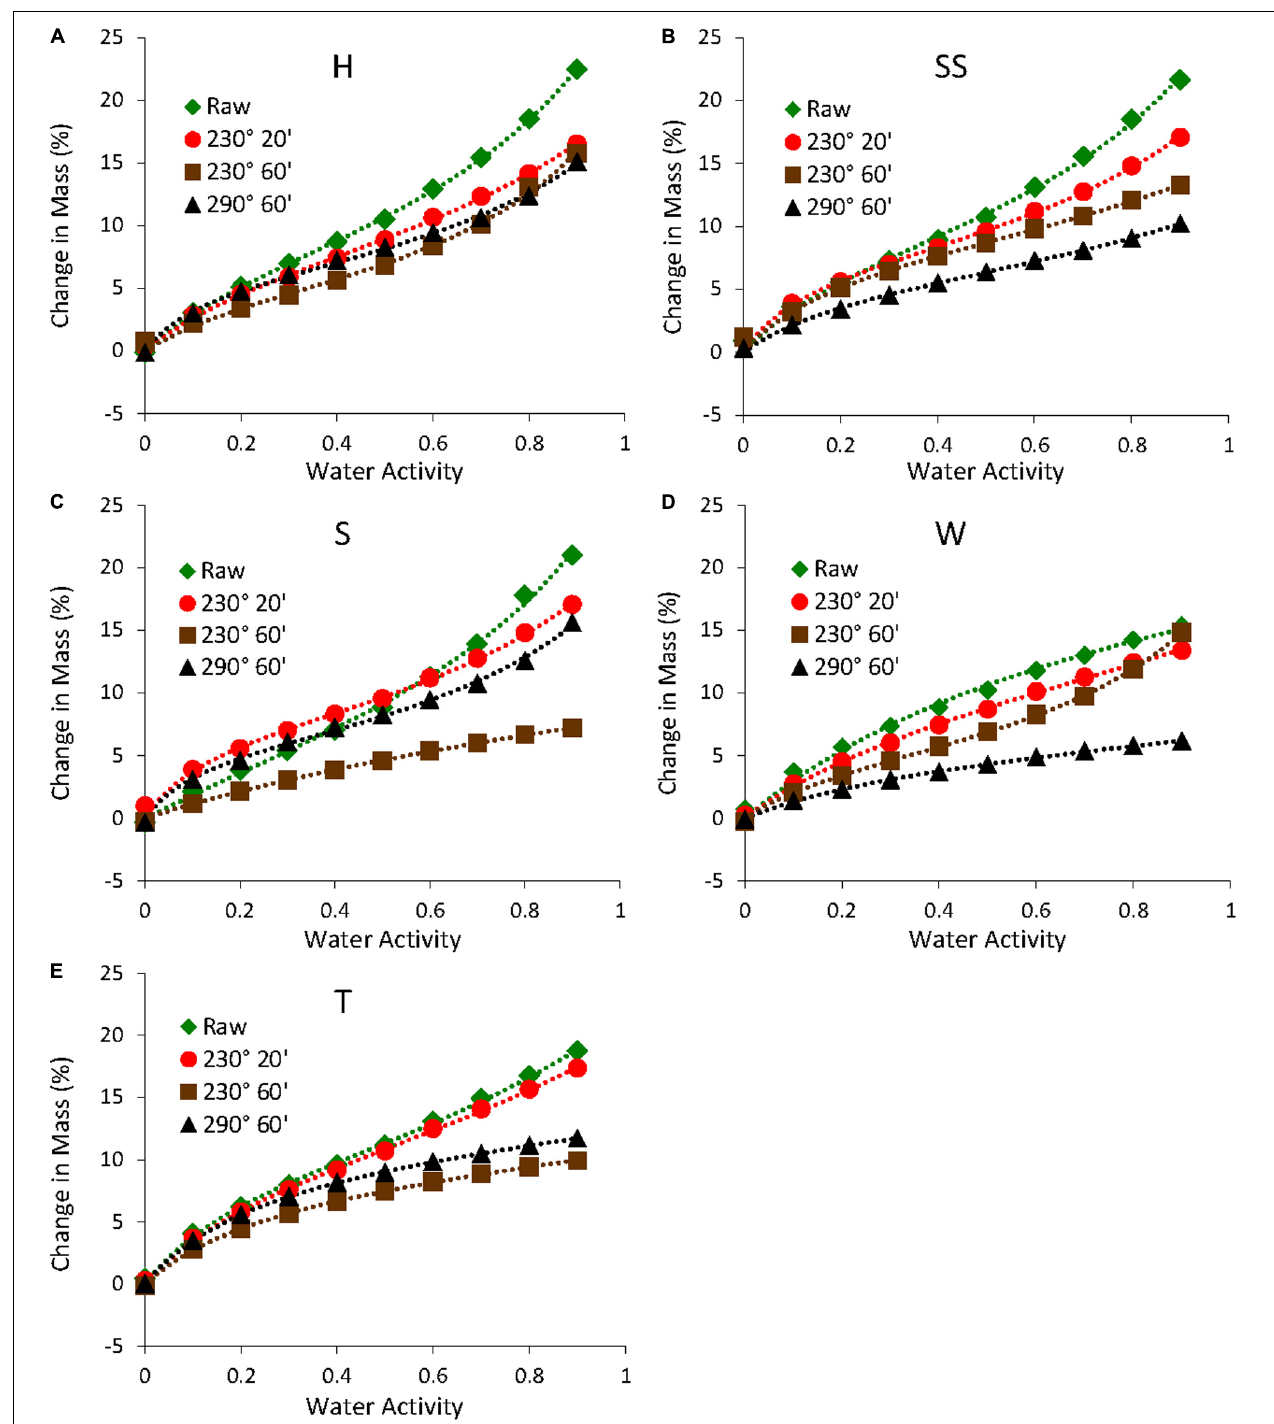
FIGURE 10 | Desorption isotherms of raw and torrefied samples (A) hard shell, (B) semi-soft, (C) soft shells, (D) walnut, and (E) twigs. The dashed lines are fits to the GAB model.